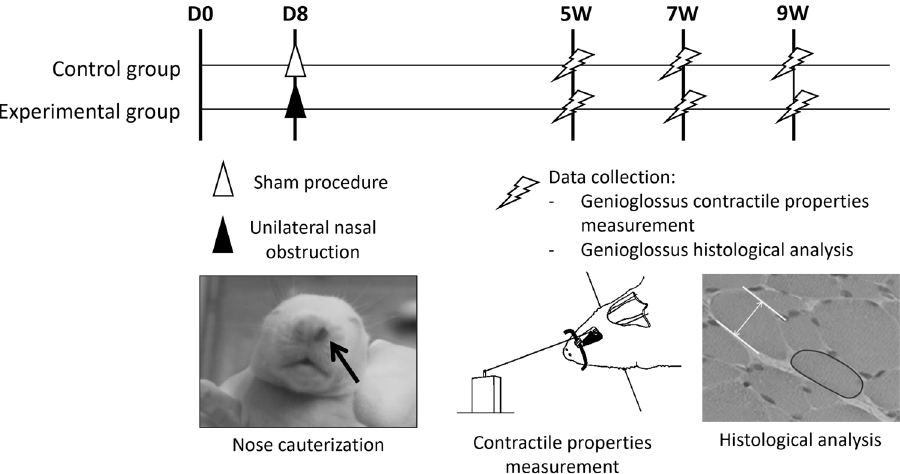
Figure 1. Organigram of experiment procedures. A sham procedure was performed at 8 days old in the control group, while a unilateral nasal obstruction by cauterization of the left nostril was performed in the experimental (nose obstruction) group at 8 days old. Data collection for the contractile properties of the genioglossus muscle, and histological analysis was performed at 5-, 7- and 9-week-old